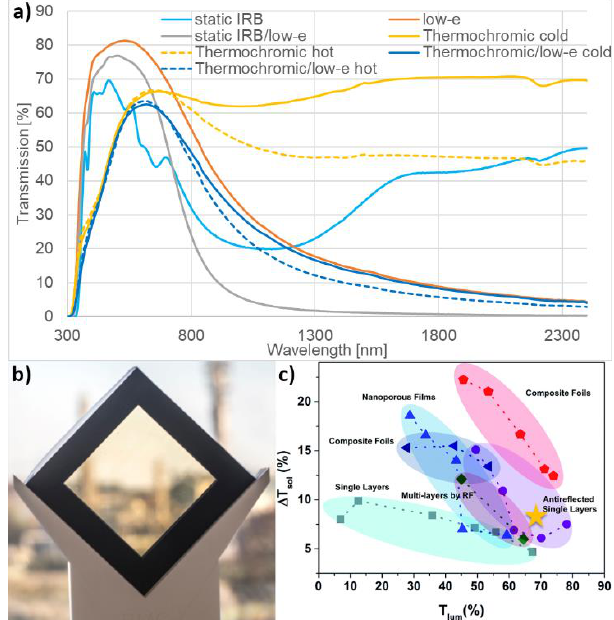
Figure 4. ( a ) Spectral data of all energy-efficient double glazing systems modeled in this study; ( b ) lab scale thermochromic / low-e double glazing developed in our labs; ( c ) combination of visible transmission ( T lum ) and solar modulation ( ∆ T sol ) of various thermochromic coatings and composite films reported in the literature (reprinted and adapted with permission from [21]), yellow star marks our thermochromic single layer coating used in this study. Table 1. Solar properties, G and U-values of all double glazing units used in this study.